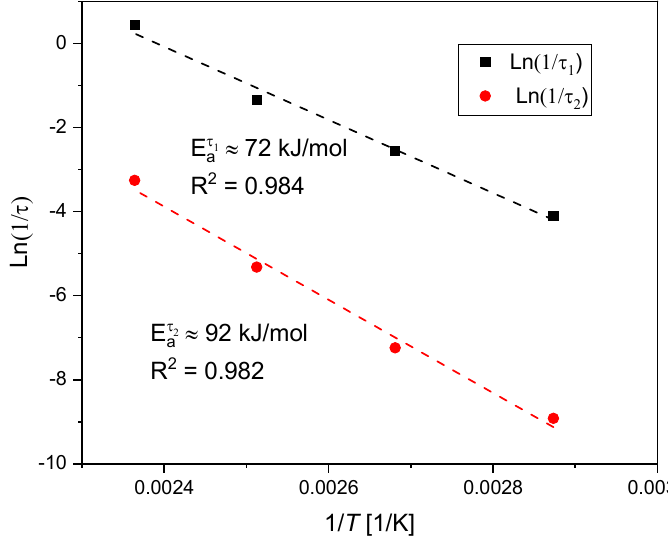
Figure 13. Assessment of the activation energy of each process based on relaxation times at different isothermal temperatures.